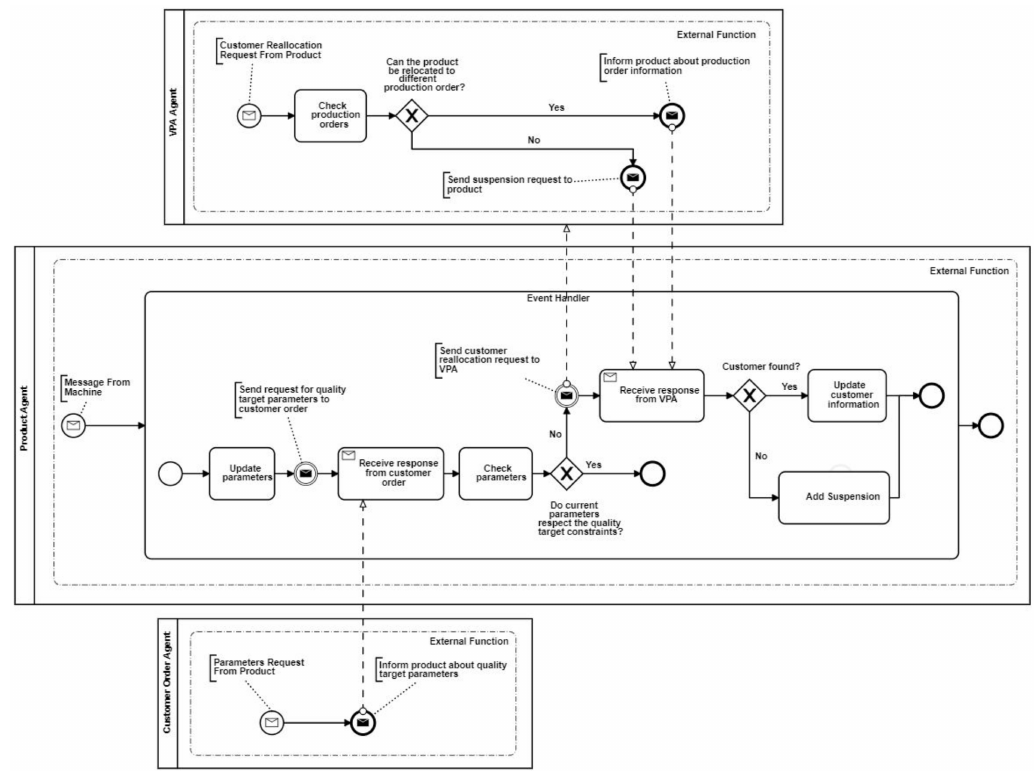
Figure 8. Interaction between Product Agent, Customer Order Agent and VPA Agent when a product reallocation is